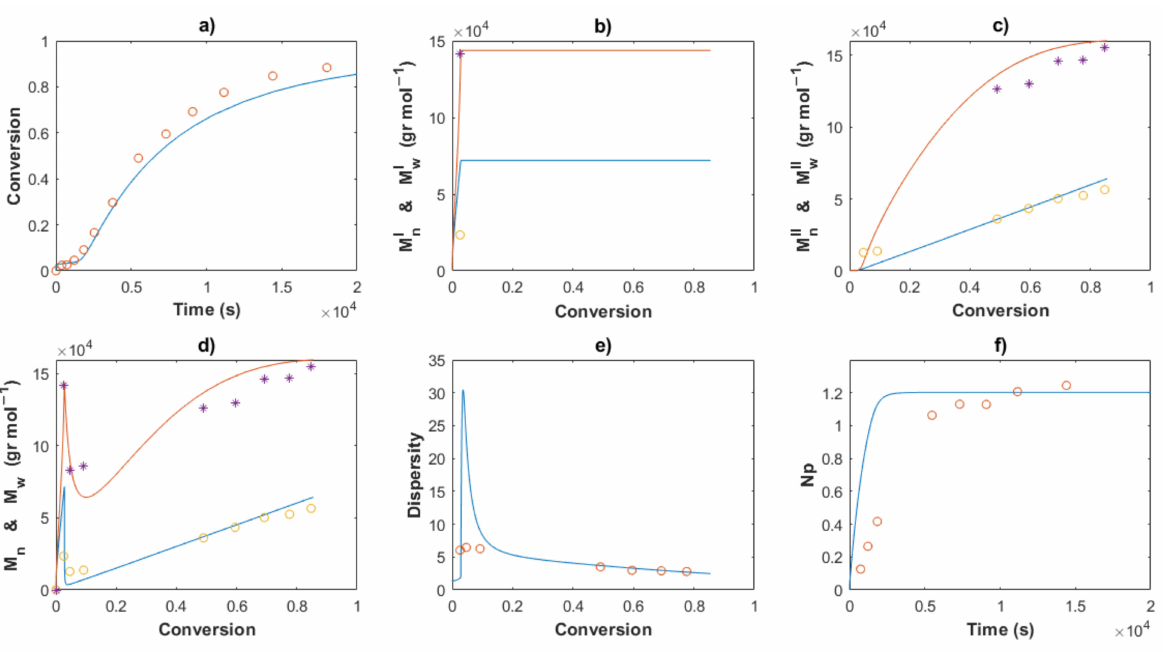
Figure 10. Comparison between the experimental data (symbols) and the model solutions (lines) for Exp 1: ( a ) Conversion profiles, ( b ) M nI and M wI versus conversion, ( c ) M nII and M wII versus conversion, ( d ) M n and M w versus conversion, ( e ) Dispersity, ( f ) Np versus time.